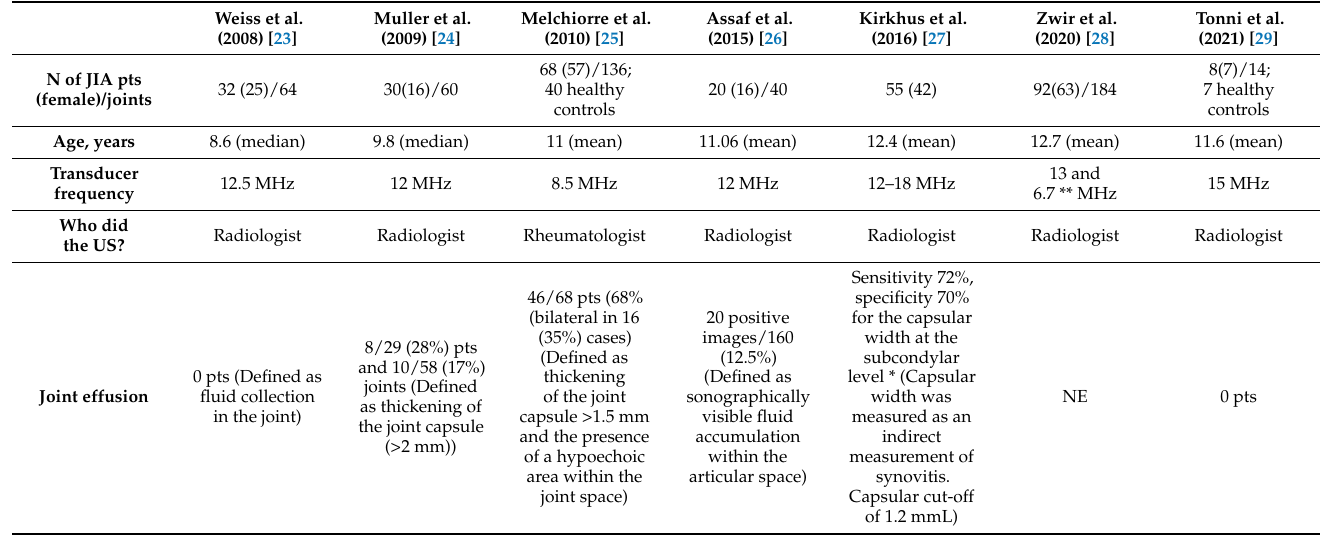
Table 3. Description of included